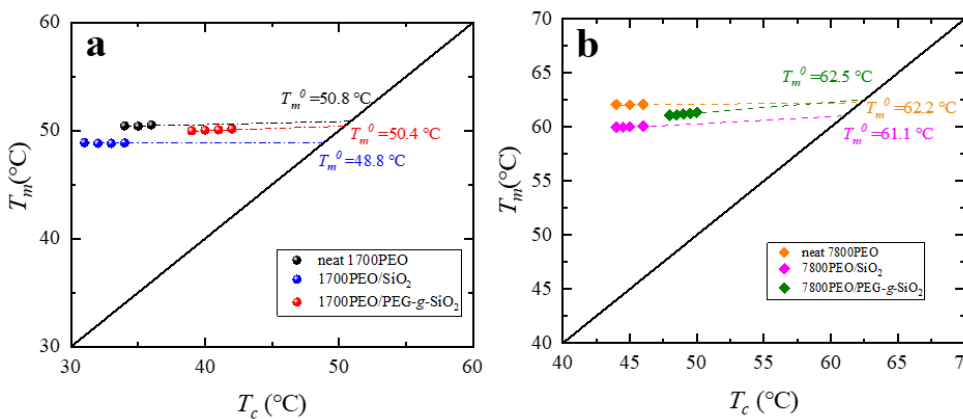
Figure A3. The equilibrium melting temperature of the PEO PNCs: ( a ) matrix M n = 1700 g/mol, ( b ) matrix M n = 7800 g/mol.